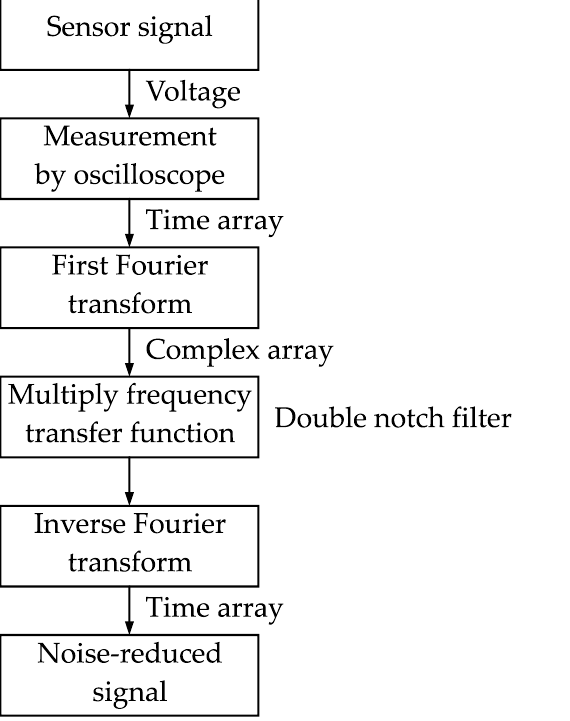
Figure 21. Flowchart of calculation to obtain transient response from frequency response.